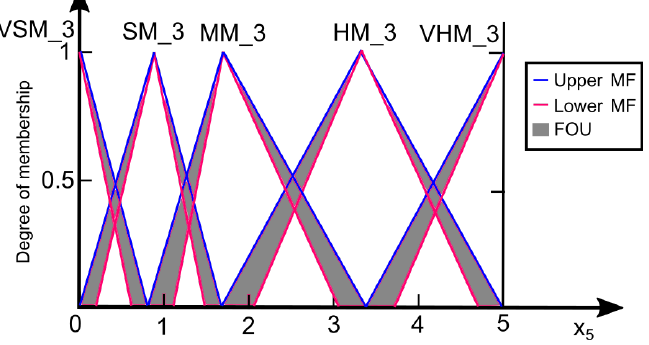
Figure 10. Input variable Average assessment of 3D space. Used notation: MF—membership function; FOU—footprint of uncertainty.